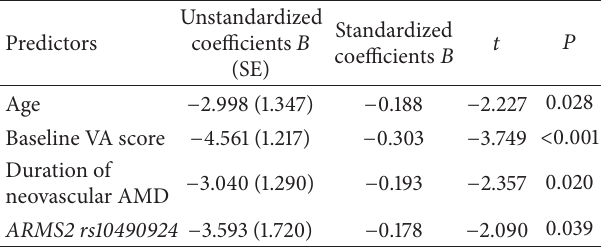
Table 4: Multivariate analysis of visual acuity score change (letters) from baseline at 6